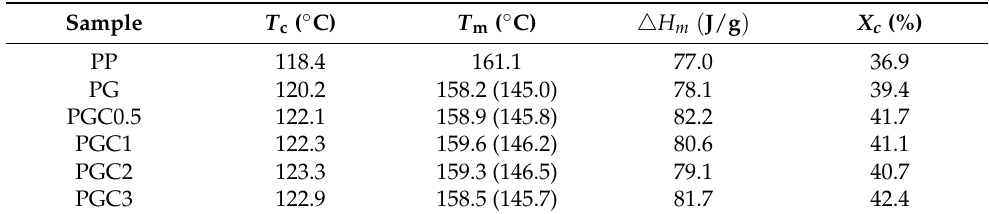
Table 2. Thermal parameters measured from the DSC tests for the neat PP and the PP/DCP/GMA/C blends with different tea polyphenols (C) loading.